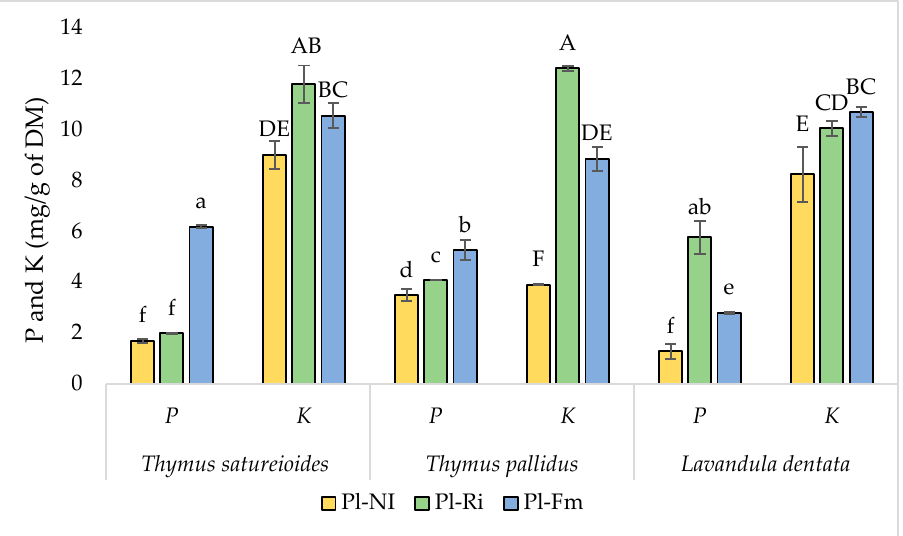
Figure 7. Phosphurus (P) and potassium (K) content (%) in Thymus satureioides (Ts), Thymus pallidus (Tp), and Lavandula dentata (Ld), non-inoculated (NI) or inoculated with Rhizophagus irregularis (Ri) or Funneliformis mosseae (Fm) after 4 months of culture under greenhouse conditions. Bars followed by the same letter are not significantly different according to Tukey’s HSD test ( p < 0.05).